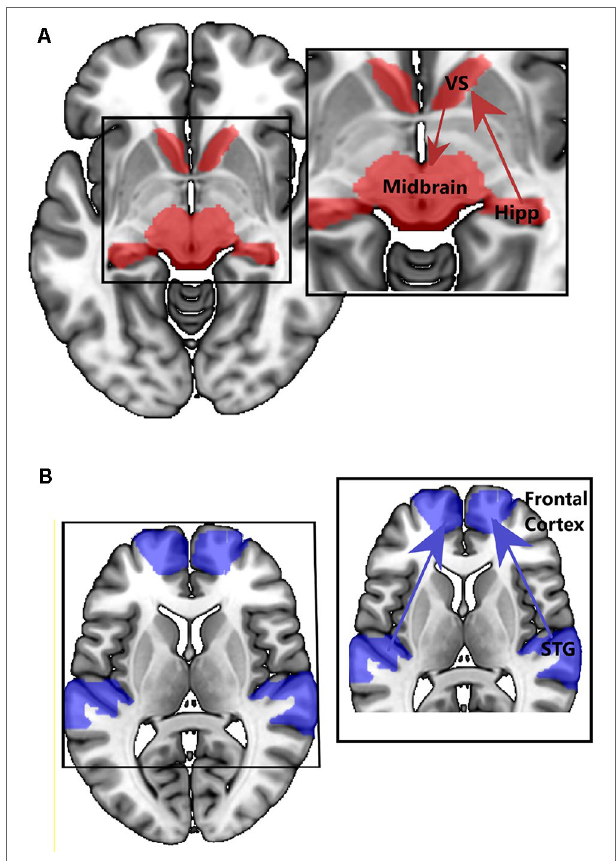
FIGURE 3 | Example of connectivity findings in CHR samples. ( A ) Increased connectivity between hippocampus and striatum, and midbrain and striatum (Modinos, et al., 2019, 96). ( B ) Decreased connectivity between STG and prefrontal regions